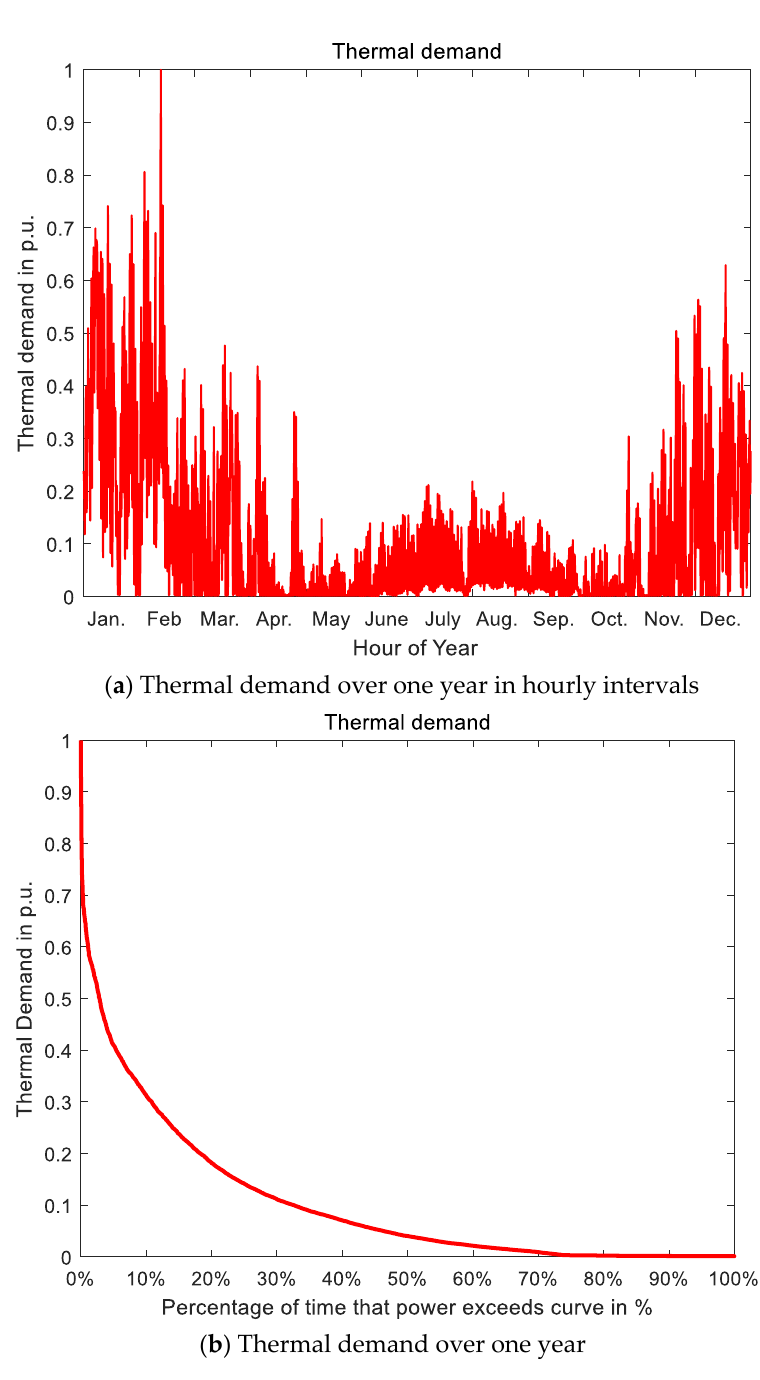
Figure 9. Yearly electric load profiles for the Atlanta area.